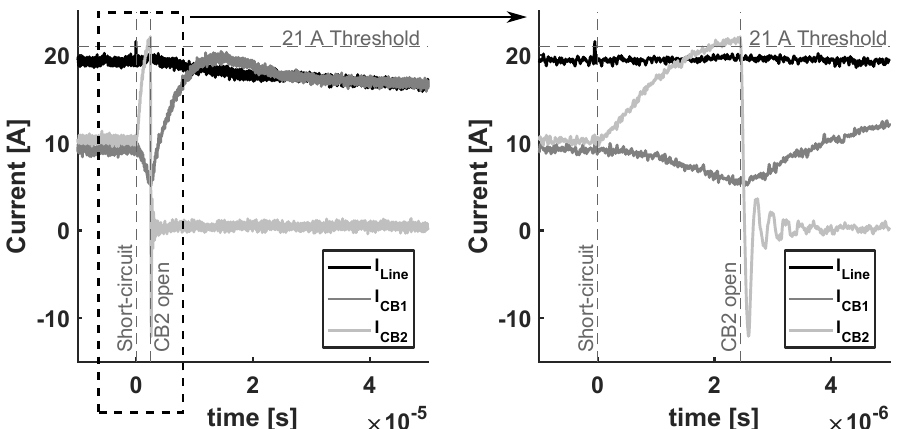
Figure 19. Experimental results for the system shown in Figure 12, which show smooth commutation and selectivity with the plug-and-play SSCBs (the right figure is a zoom in).